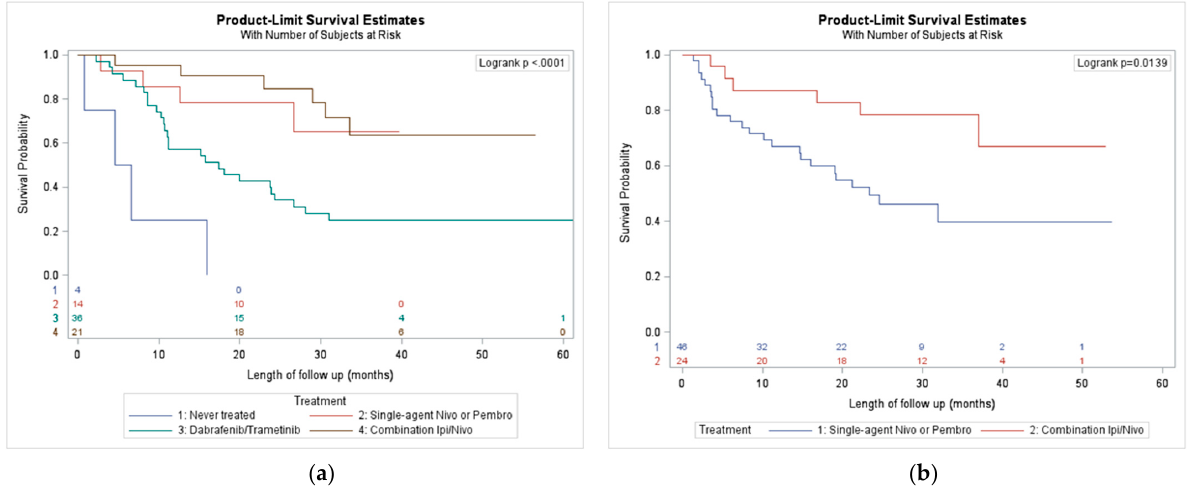
Figure 2. ( a ) Overall survival outcomes by first treatment received of BRAF mutation positive; ( b ) overall survival outcomes by first treatment received, in BRAF wild type/Unknown.